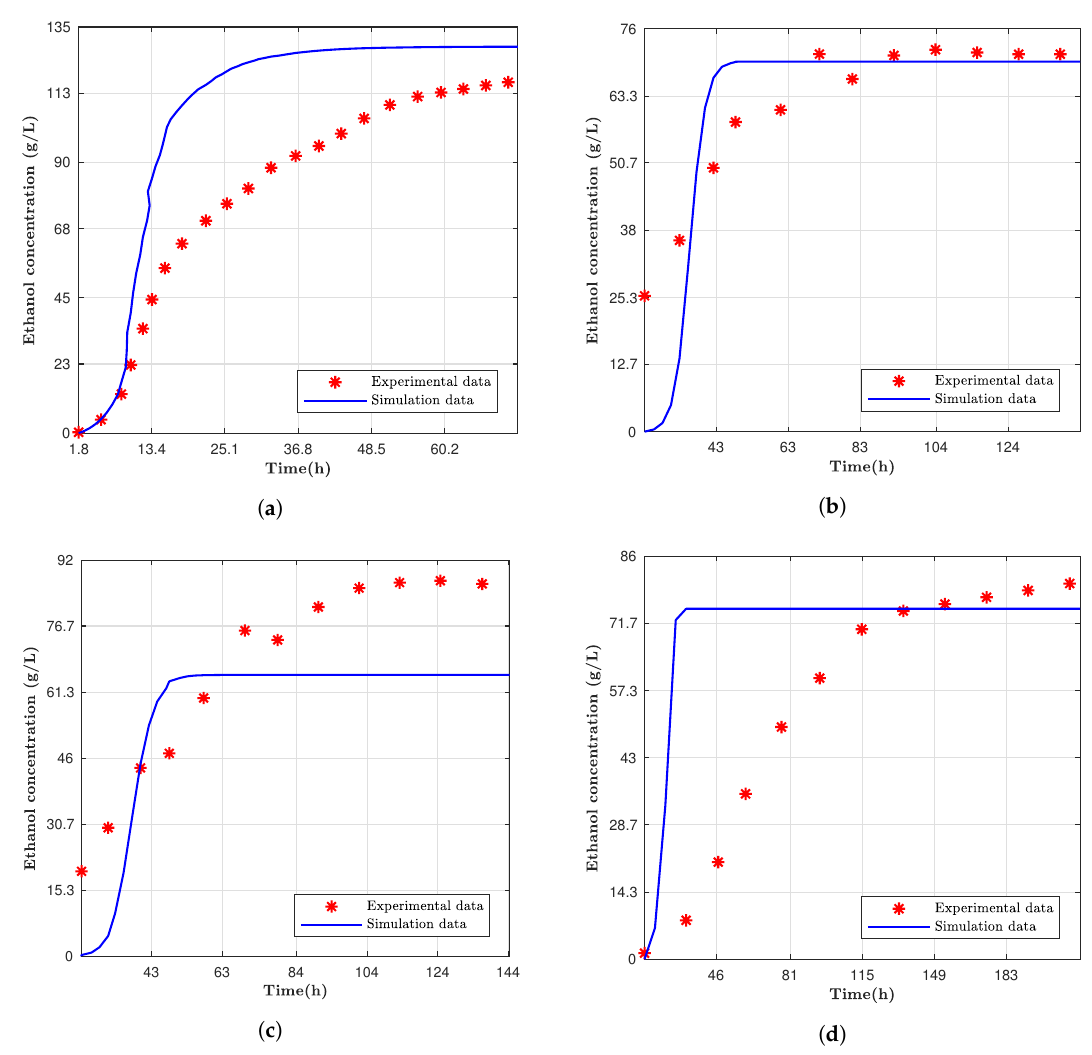
Figure 2. Simulation data compared to experimental data from ( a ) Devantier et al. [12]; ( b ) Nguyen et al. [11] with carbon starvation at 37 ◦ C and ( c ) 30 ◦ C, and ( d ) both without carbon starvation at 37 ◦ C. Table 4. Comparison between experimental and computational